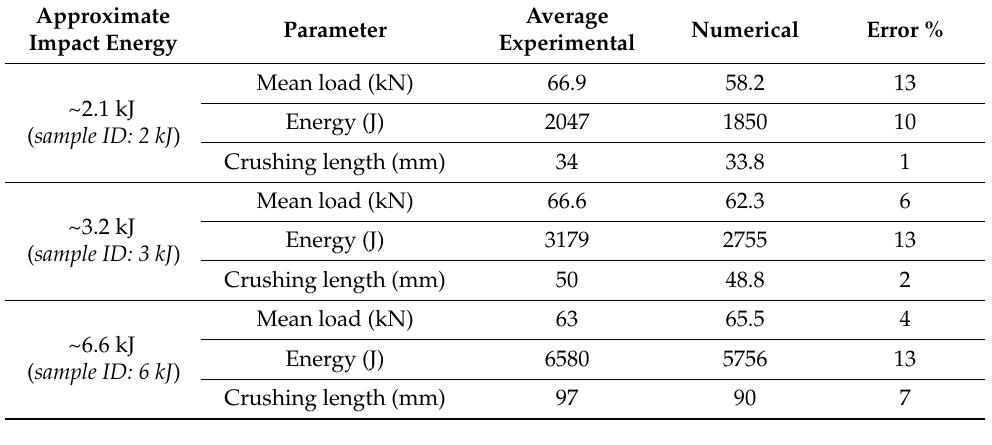
Table 2. Predicted and experimental results for composite material reinforced closed top-hat.